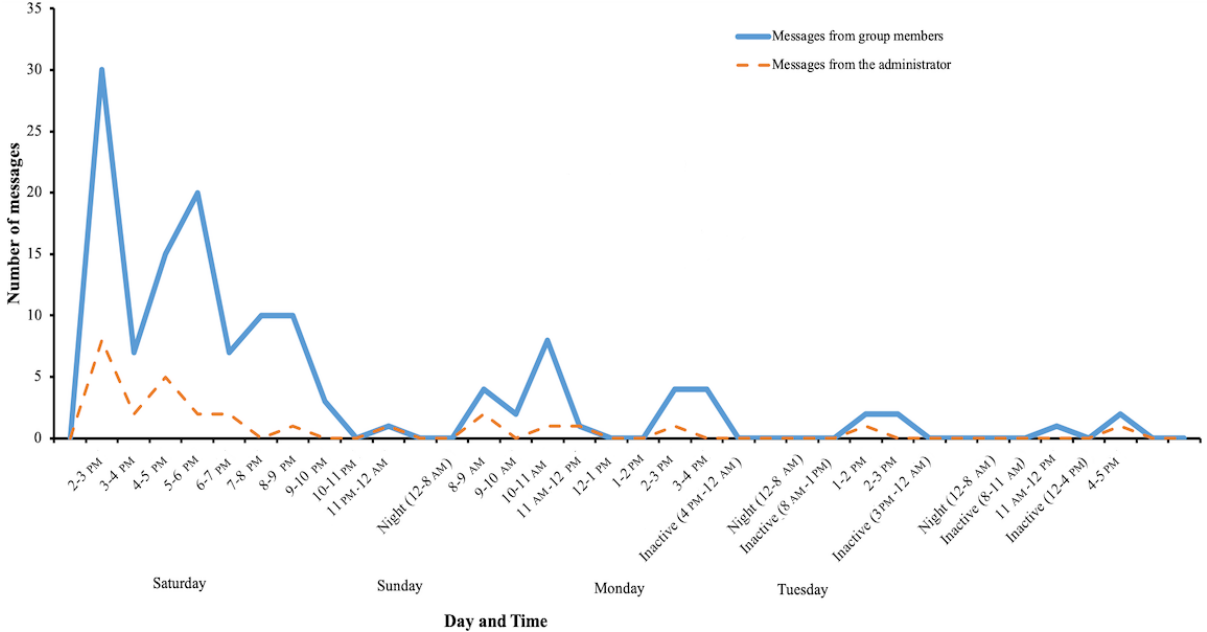
Figure 3. Number and time distribution of the messages from the members versus those from the